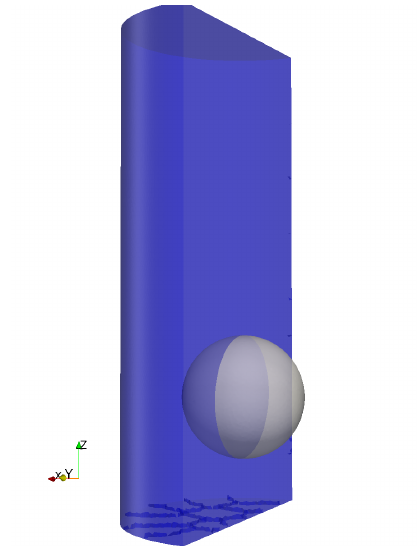
Figure 1. Initial setup for the benchmark.